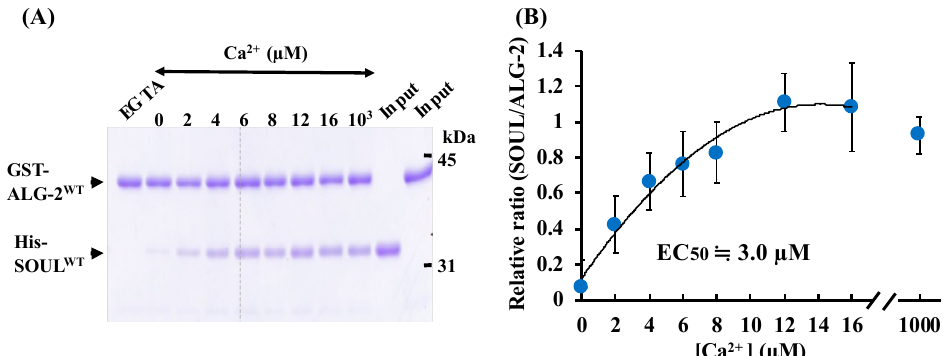
Figure 2. Effects of Ca 2+ or EGTA on the interaction between SOUL and ALG-2. ( A ) GST-pulldown assays of GST-ALG-2 WT with His-SOUL WT in the presence of various amounts of Ca 2+ or 1 mM EGTA in vitro. ( B ) Relationship between [Ca 2+ ] and the binding activity. The activity is represented as a relative value of the SOUL/ALG-2 quantified by Multi Gauge version 2.1. Each value is the mean of at least three independent experiments ± SD.